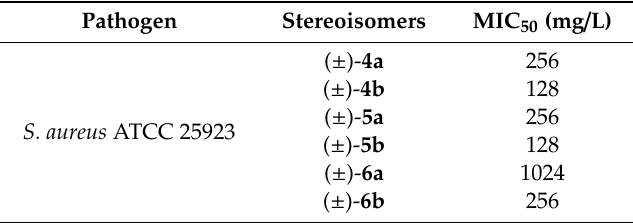
Table 5. Minimal inhibitory concentrations are e ff ective for ≥ 50% for 4–6 against S. aureus ATCC